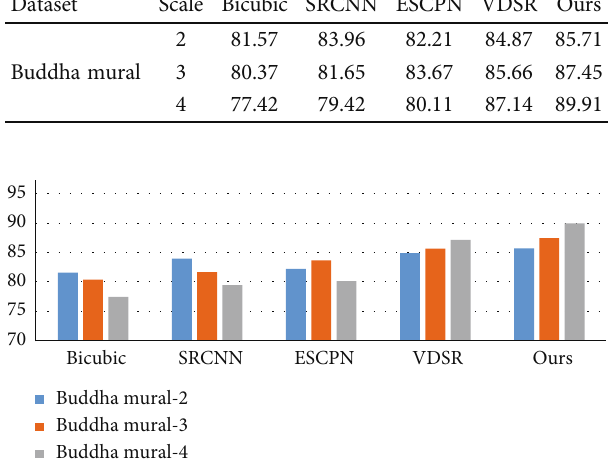
Table 1: The classi fi cation results of the mural image test set. Dataset